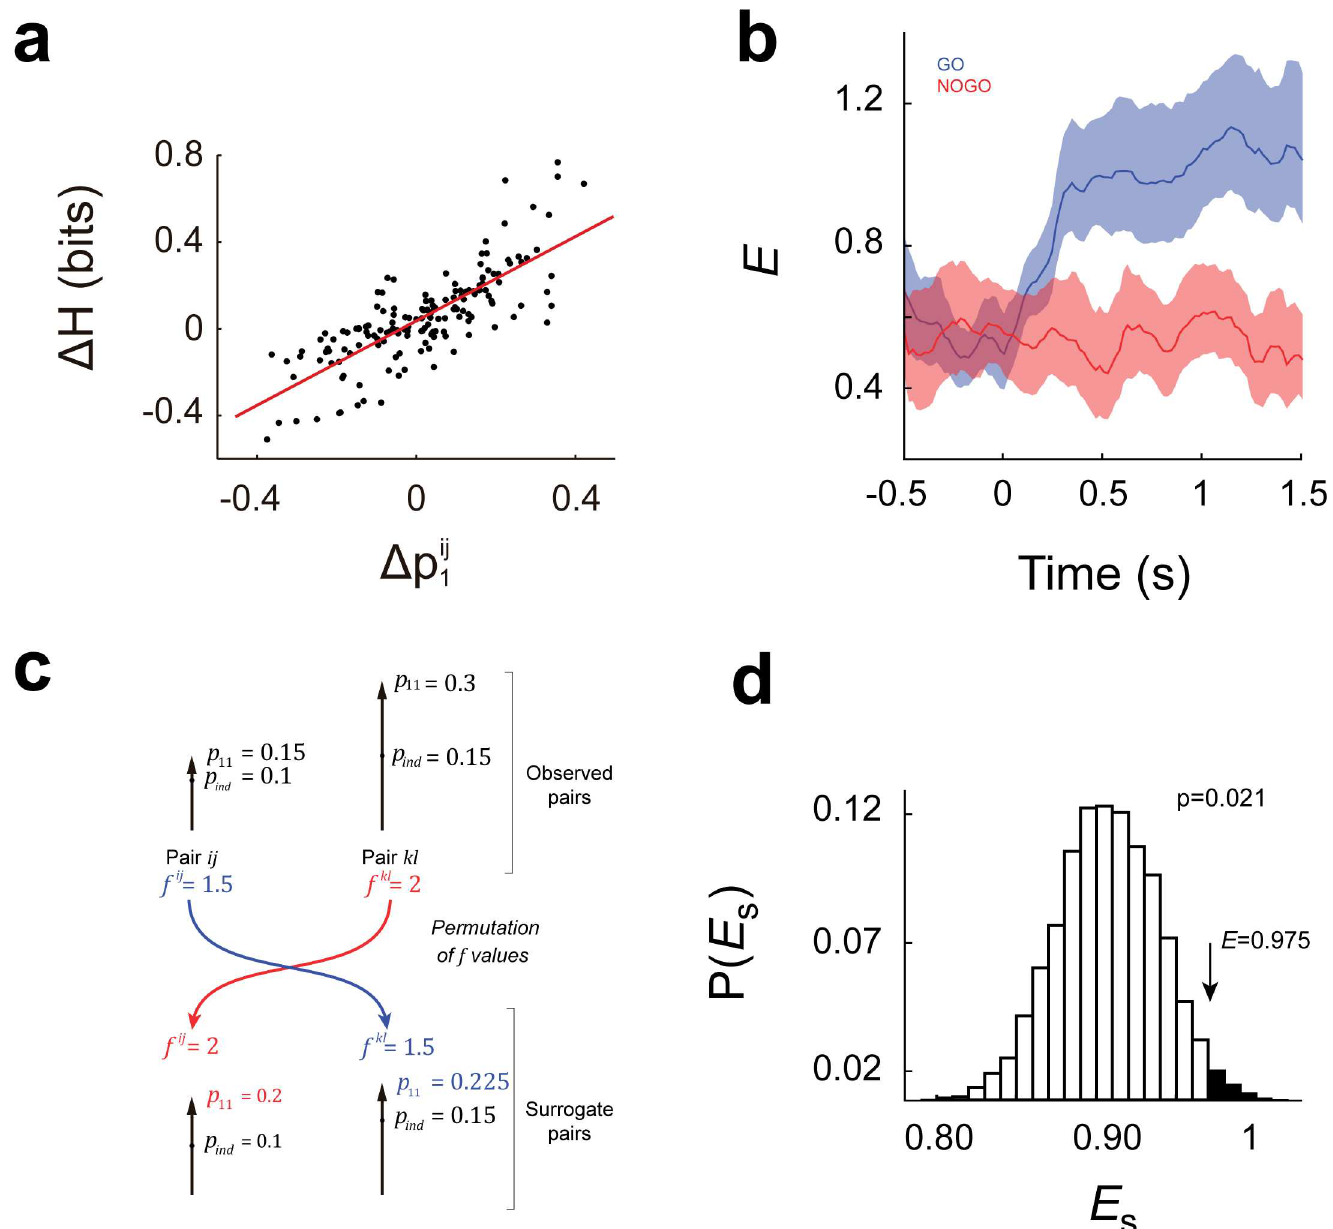
¼ D p i þ D p j Fig 3. The cost of rising entropy in the PFC. (a) Entropy changes Δ H as a function of marginalprobabilitychanges D p ij in the case of GO 1 1 1 correct trials. Changeswere computedbetween+0.5 s and -1 s from stimuli onset. Each dot corresponds to a neuronpair. The linear regression is shown in red, and efficiency E is definedas the slope if the regression(slope = 0.97, 95% CI = [0.85,1.09], assessedby bootstrapping). (b) Efficiency dynamics along GO and NOGO trials. Efficiency increasesas soon as the stimuli is presented in the case of GO trials whereasno differenceswere observedin the NOGO case ( E values and CI are shown). (c) Surrogatepairs were built by changing only the p 11 values observed duringstimulus presentation(no changes were made for basal p 11 , p i and p j values, neither for p i and p j values duringstimulus presentation). The scheme represents two pairs of 1 1 1 1 neurons, composedof neurons i and j , and neurons k and l . Each pair has its p 11 (full lengthof the arrow) and its p ind (length till black dot). Additionally, each pair has its f value, which is the quotient betweenthe observed p 11 and the p ind . Surrogates are then constructed by exchanging f values and multiplyingthe original p ind with the f value of the other pair, thus obtaininga surrogate p 11 value ( p surr ). Only f values of pairs belongingto the same 11 session were permuted. (d) Assessing the role p 11 in efficiency. A thousandsurrogate values of E were generatedby changing the probabilityof coincidence p 11 as describedin (c) in order to build the null distribution P ( E s ). Efficiency measuredfrom our data ( E = 0 . 975) is significantly higherthan the expectedby chance ( P = 0.021).